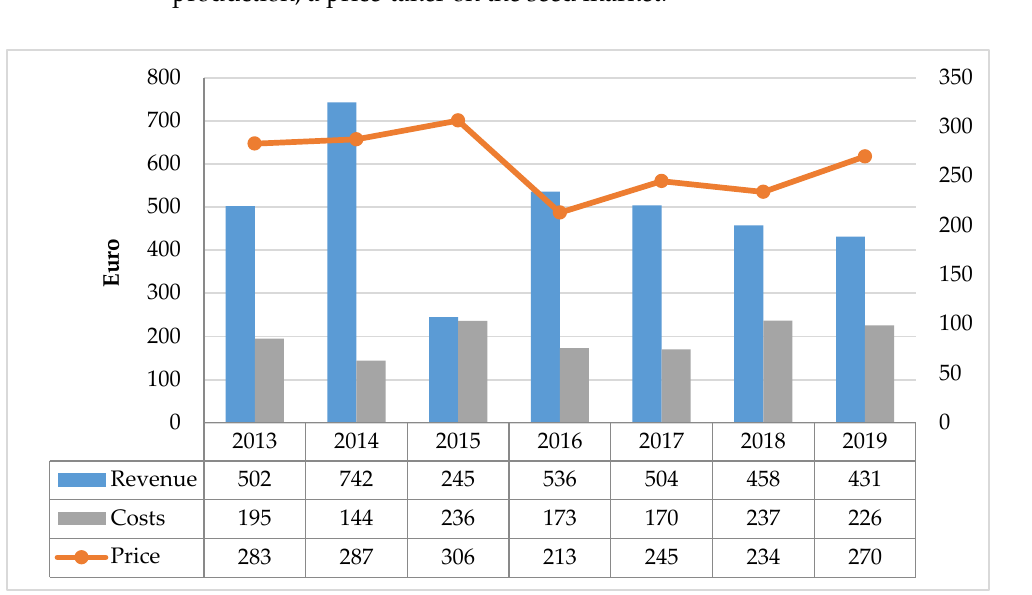
Figure 3. Incidence of the single variable cost categories as parts of the total variable costs. The cost for the seed represents the cost category that mainly affects variable costs (on average about 30%). This shows that seed companies play an important role in the cereal supply chain, capable of influencing the market prices of seeds. It is interesting to note that the cost of fertilisers and pesticides, in the second and third levels of significance, remain stable over time, even after the process of technological adoption. However, by